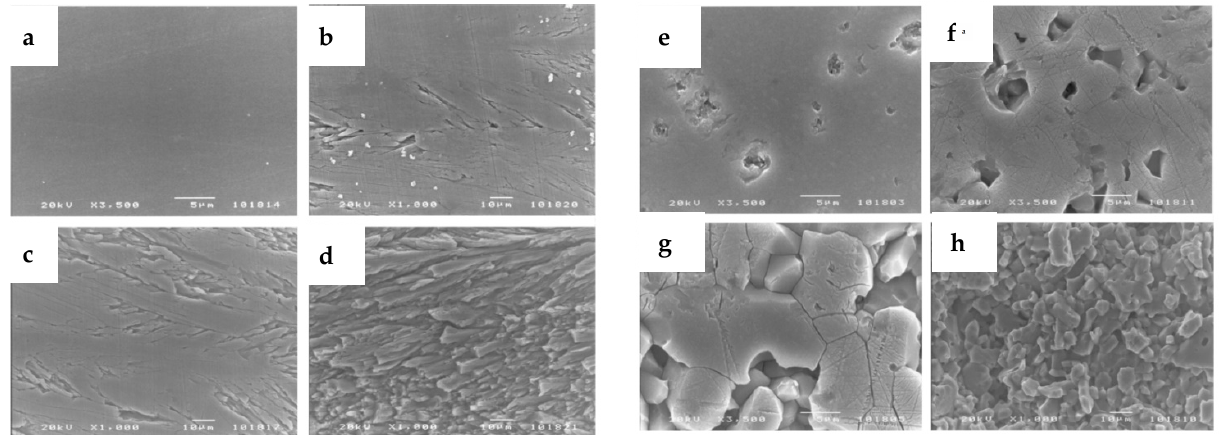
Figure 31. Surface microstructures of the ( Left )—( a ) as-polished and corroded SSiC specimens after corrosion testing for ( b ) 1, ( c ) 5 and ( d ) 7 days in water at 360 °C and ( Right )—( e ) as-polished and corroded CVD SiC specimens after corrosion testing for ( f ) 3, ( g ) 7 and ( h ) 10 days in water at 360 °C. Reprinted with permission from Reference [91]. Copyright 2003 Springer Nature.